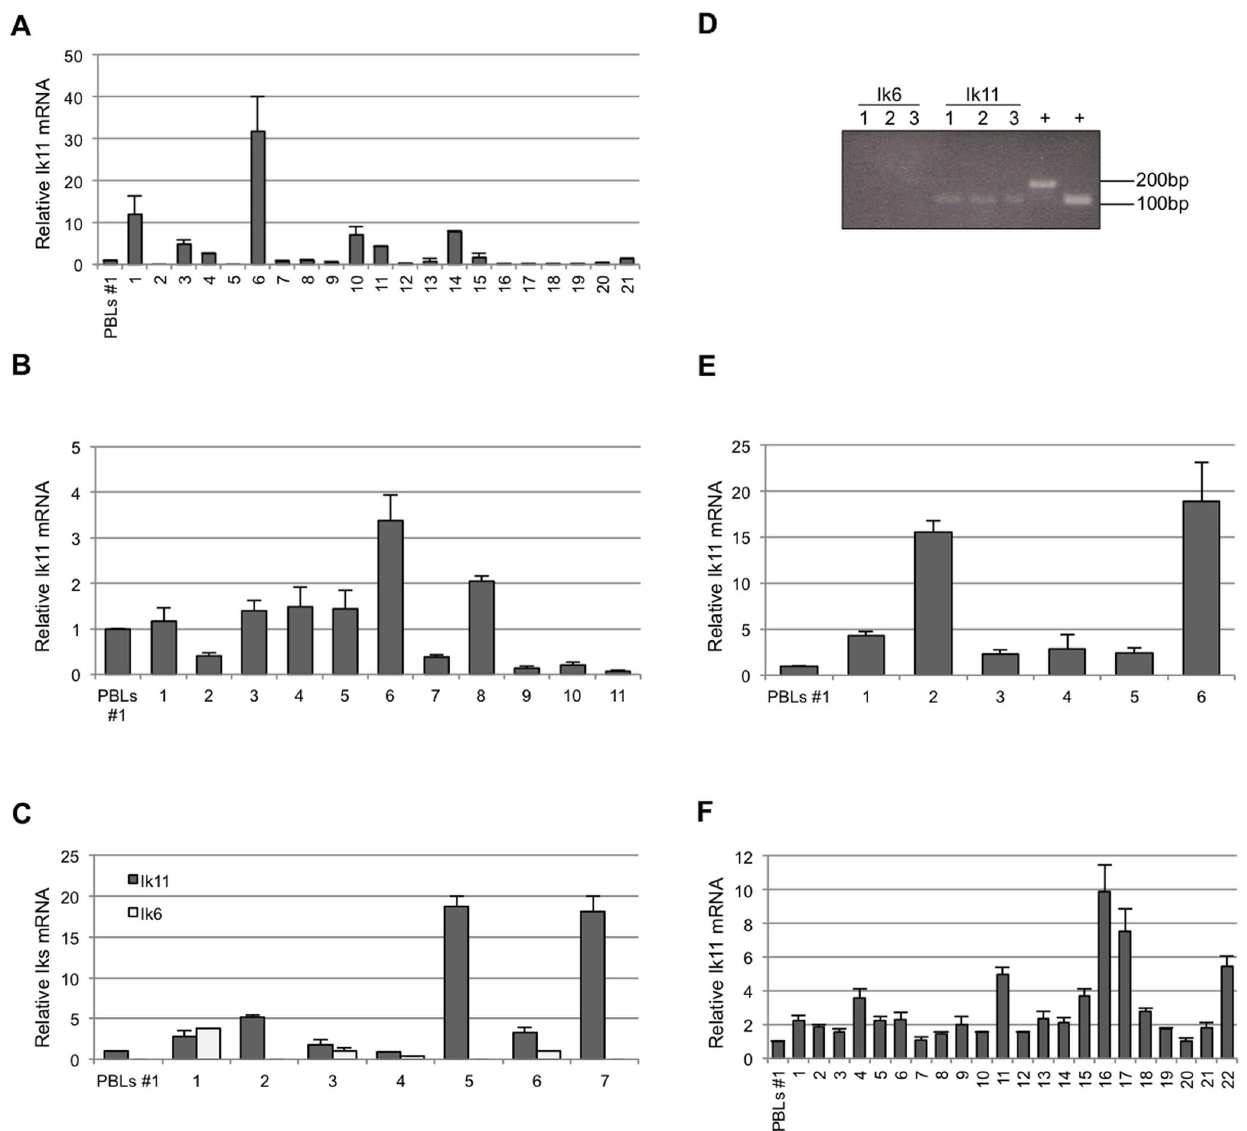
are expressed as fold change relative to expression in PBLs obtained from the healthy donor # 1 (see Figure S3) and normalized to the expression of GAPDH. Each bar represents the average 6 SD of three replicates. ( D ) Expression of Ik11 and Ik6 in commercial samples of lymphoproliferative disorders (n=3). 1=Poorly differentiated malignant lymphoma; 2=Hodgkin’s lymphoma; 3=non-Hodgkin’s lymphoma, diffuse; + =PCR positive controls. ( E, F ) Real-time PCR analysis of Ik11 and Ik6 mRNAs in samples of lymphoma (E, n=7) and chronic lymphoblastic leukemia (F, n=22). The Ik11 levels are expressed as fold change relative to expression in PBLs obtained from the healthy donor # 1 (see Figure S3) and normalized to the expression of GAPDH. Each bar represents the average 6 SD of three